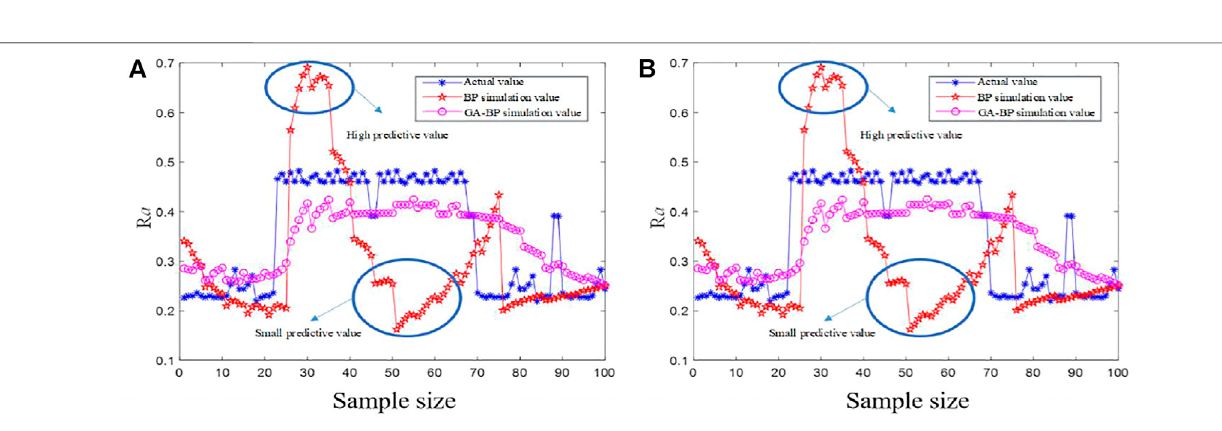
600 sets of experimental data obtained are used as the data for the algorithm, 500 sets are used as the algorithm training data, and 100 sets are used as the data for the algorithm test.